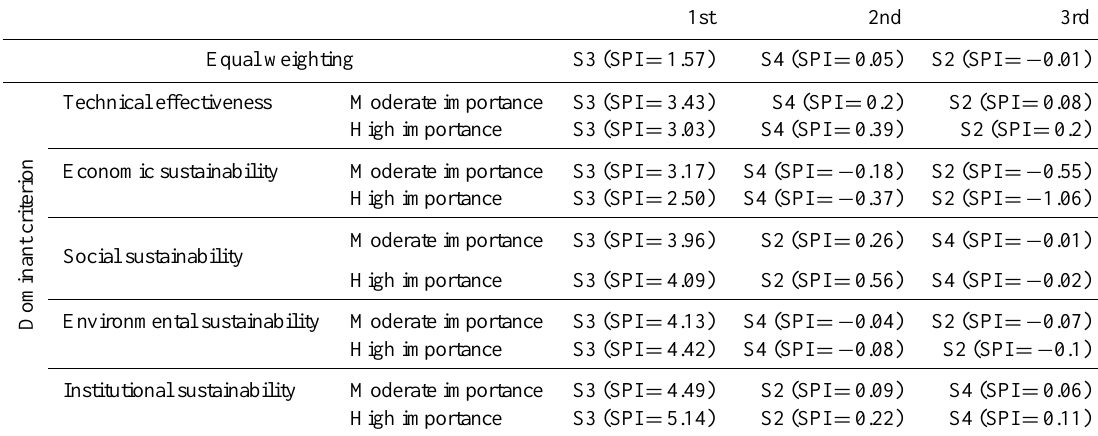
Table 10. Options ranking based on SPIs calculated with various weighting factors (using a twenty-one-point scale).